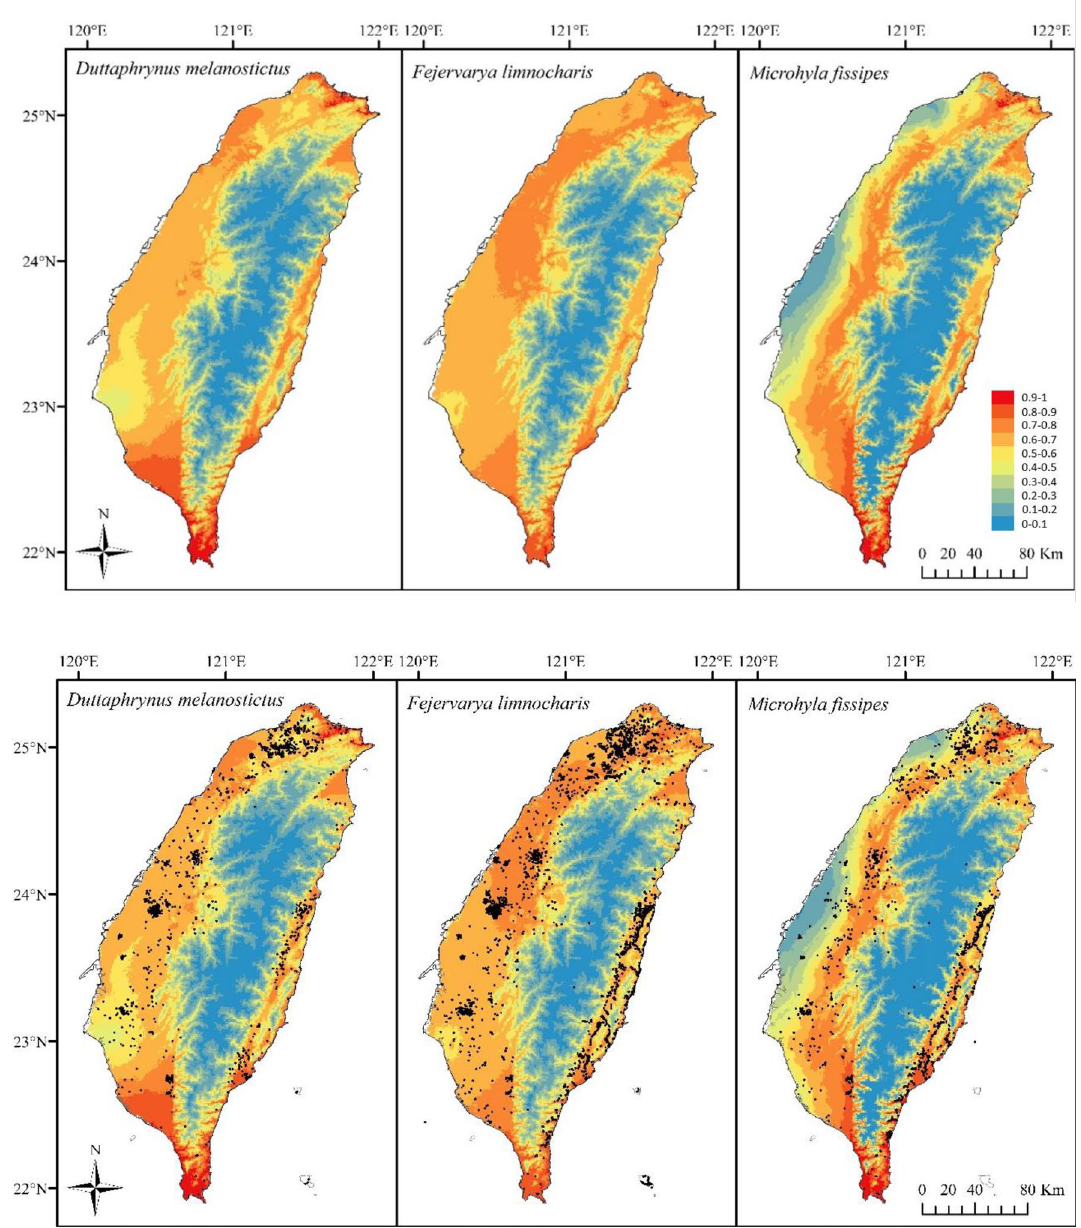
Figure 5. Suitability for three species ( Duttaphrynus melanostictus , Fejervarya limnocharis , and Microhyla fissipes ). Maps were modelled in MaxEnt using 19 bioclimatic variables 57 . Suitability ranges from low (blue) to high (red) with species primarily distributed in lowlands and coastal areas. Maps were generated by D. Andersen under ArcMap 10.6 (ESRI, Redlands, CA, CTmax of F. limnocharis tadpoles was in relation to the development stage after exposed to salinity treatments (Spearman’s r = 0.75, n = 32, p < 0.001; Fig. 4 middle). The expected distribution and coastal flooding area. MaxEnt models for the three species showed similar patterns of suitability across Taiwan (Fig. 5). Areas under the curve (AUC), or model fit, were 0.719, 0.734, and 0.771 for D. melanostictus , F. limnocharis , and M. fissipes , respectively. The area with a suitability over 0.5 covered 19,091 km 2 for D. melanostictus , 20,811 km 2 for F. limnocharis , and 15,340 km 2 for M. fissipes . Suit- able climate for D. melanostictus and F. limnocharis were found in low to middle elevations, while M. fissipes was distributed more broadly at intermediate elevations. Under the current climate, only F. limnocharis is predicted to occur in areas where Tmax is reaching CTmax for high salinity conditions (Fig. 6, top row). For year 2081–2100 predicted climate, however, high salinity CTmax